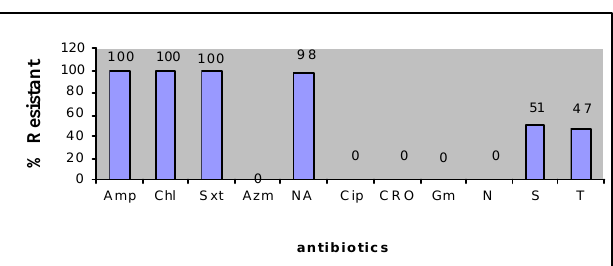
Fig. 5 : Antimicrobial susceptibility of Salmonella isolated in 2004